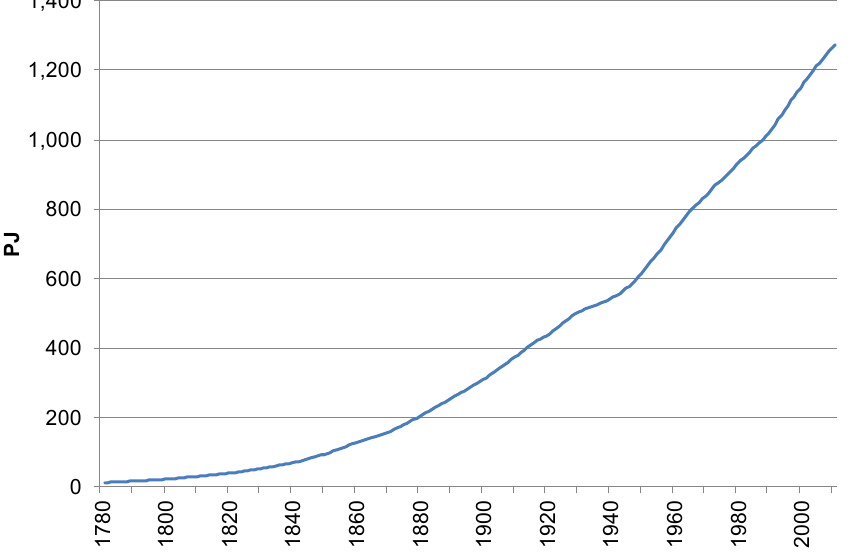
Figure 1. Food consumption in the United States, 1780–2010. Sources: Population from [6]; food input estimated at 2700 calories per day per person based on [4,6].